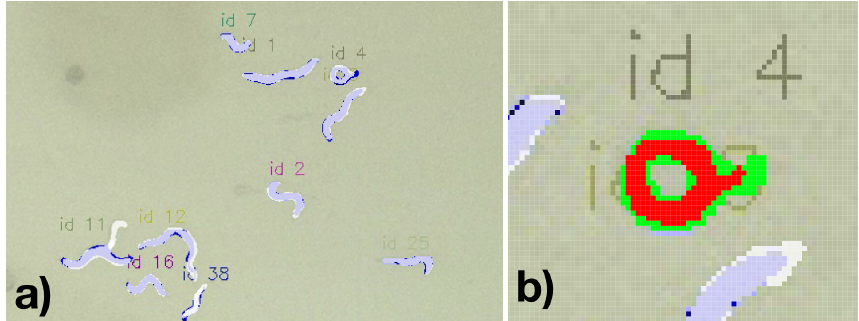
Figure 9. ( a ) Detected (blue) and annotated (white) nematode mask and ( b ) for a specific nematode (overlapping pixels among annotation and detected